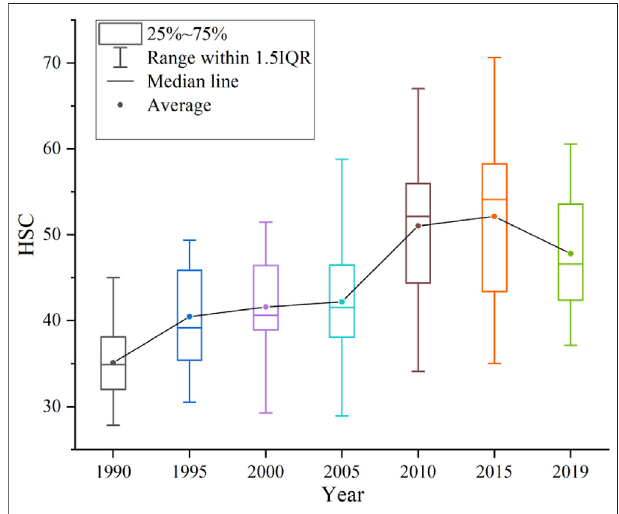
FIGURE 3 | Temporal evolution of